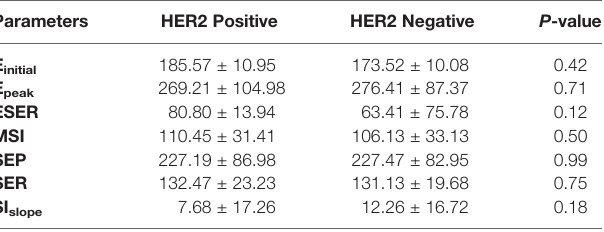
TABLE 3 | Comparison results of the average value of seven kinetic parameters from the lesion area.